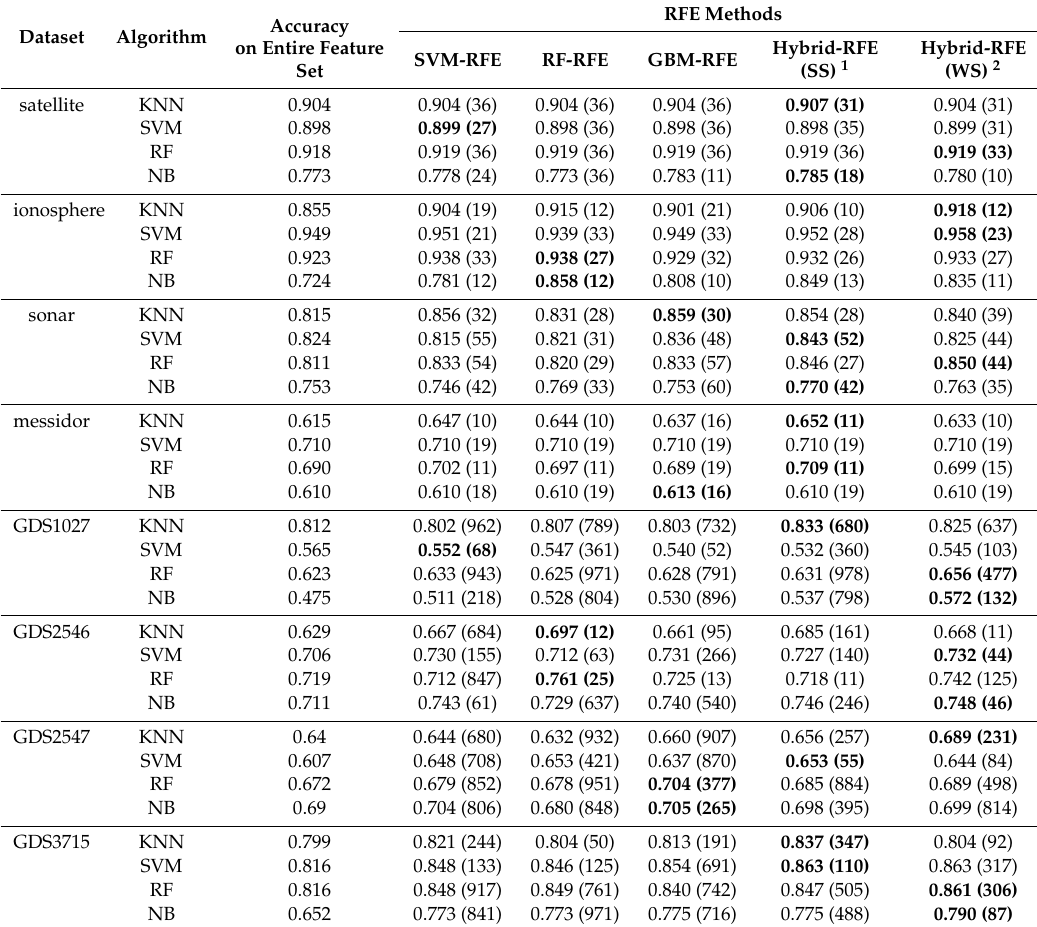
Table 3. Experimental